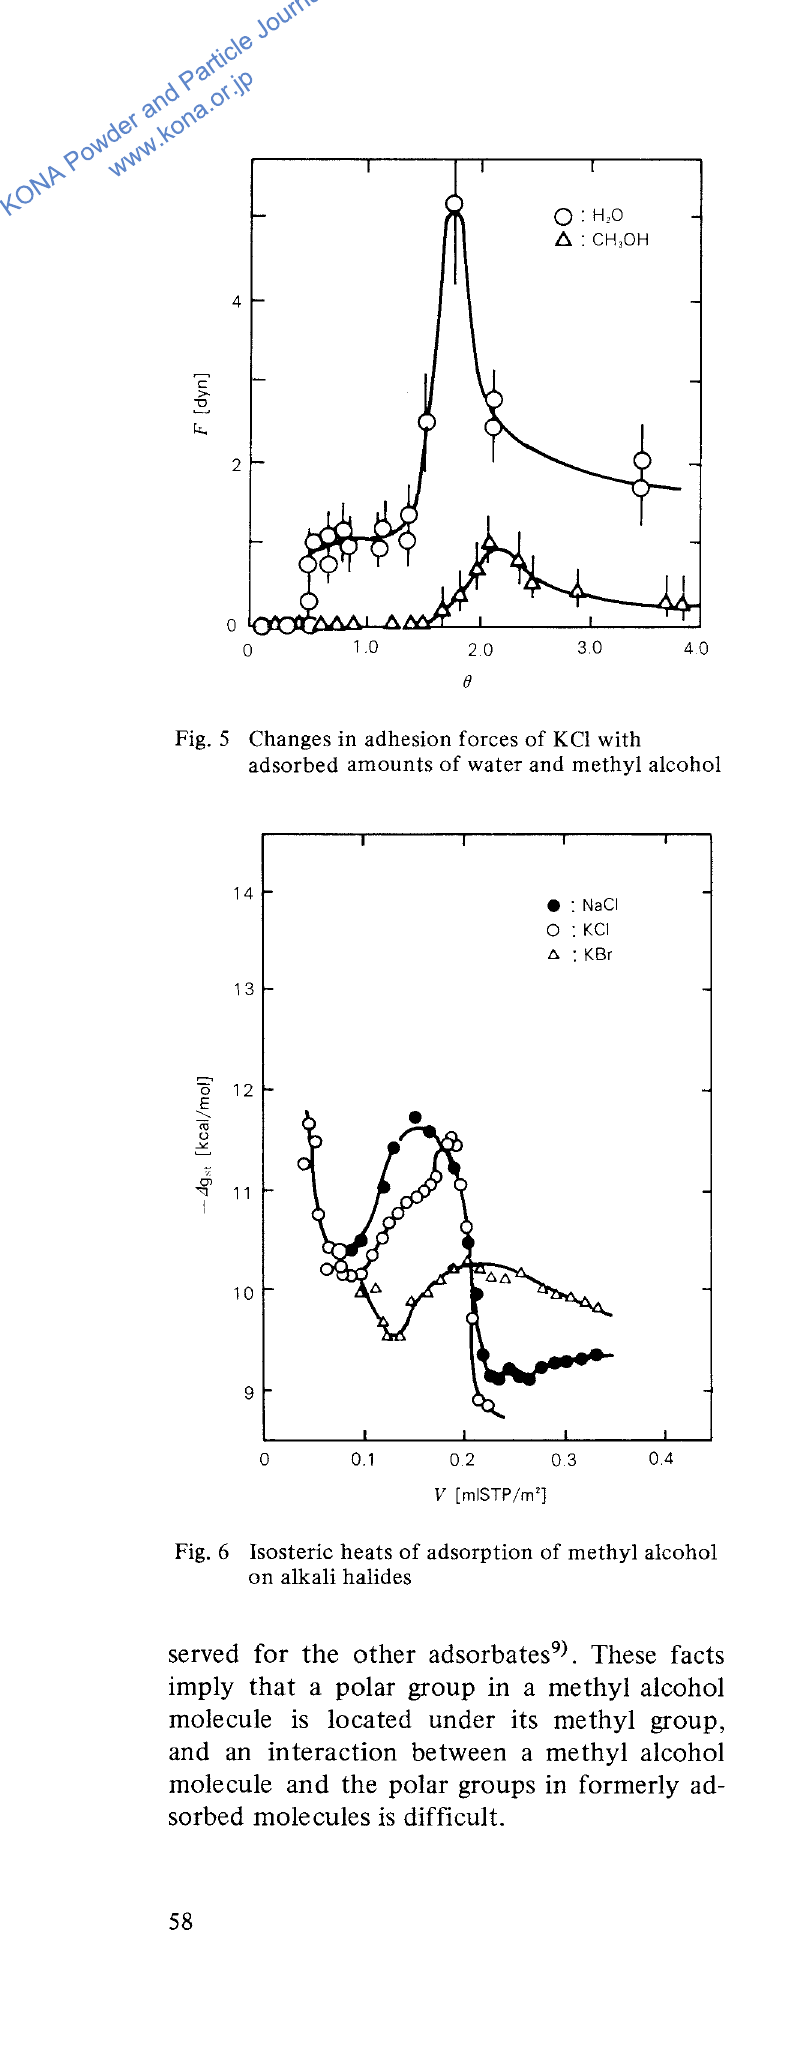
Fig. 6 Isosteric heats of adsorption of methyl alcohol on alkali